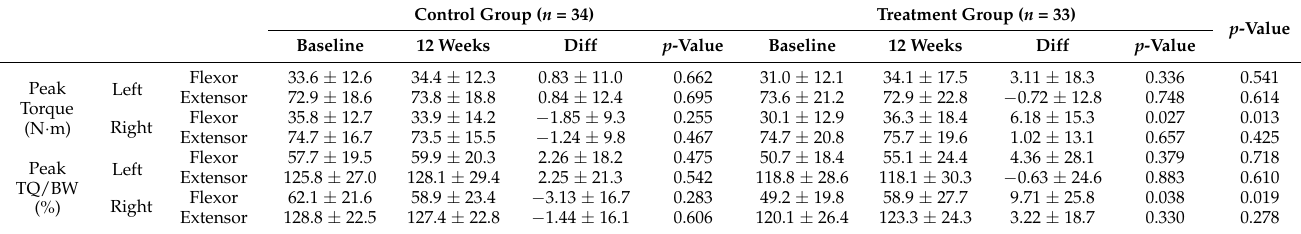
Table 2. Effects of tannase-treated green tea extract on isokinetic muscular strength. Control Group ( n = 34)